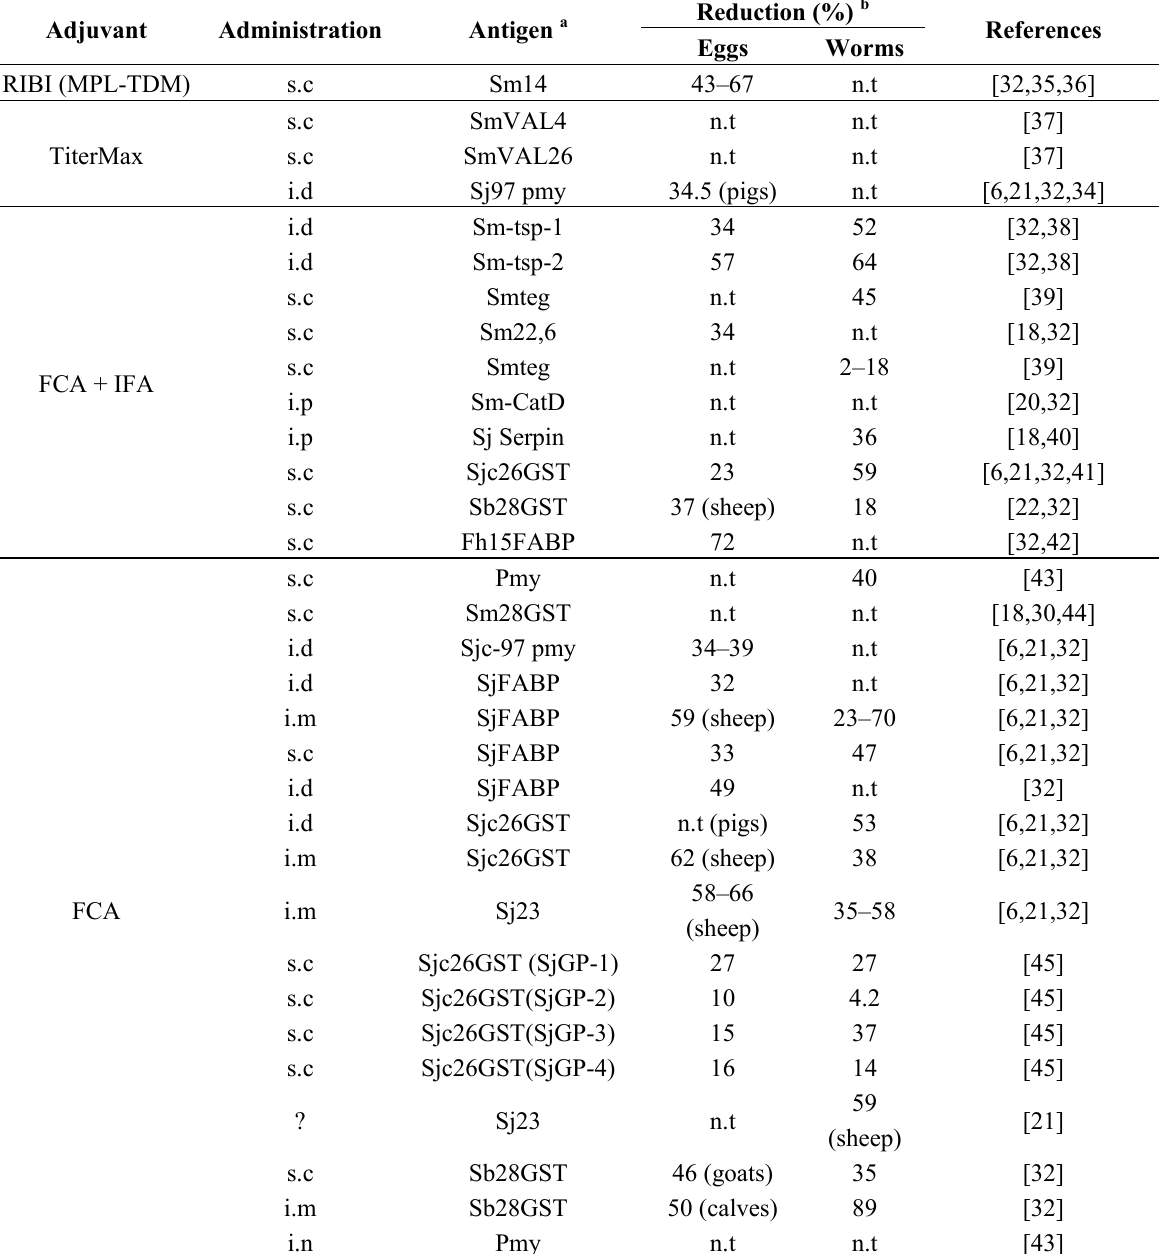
Table 4. Emulsion-adjuvanted Schistosoma vaccine candidates classified as a function of the